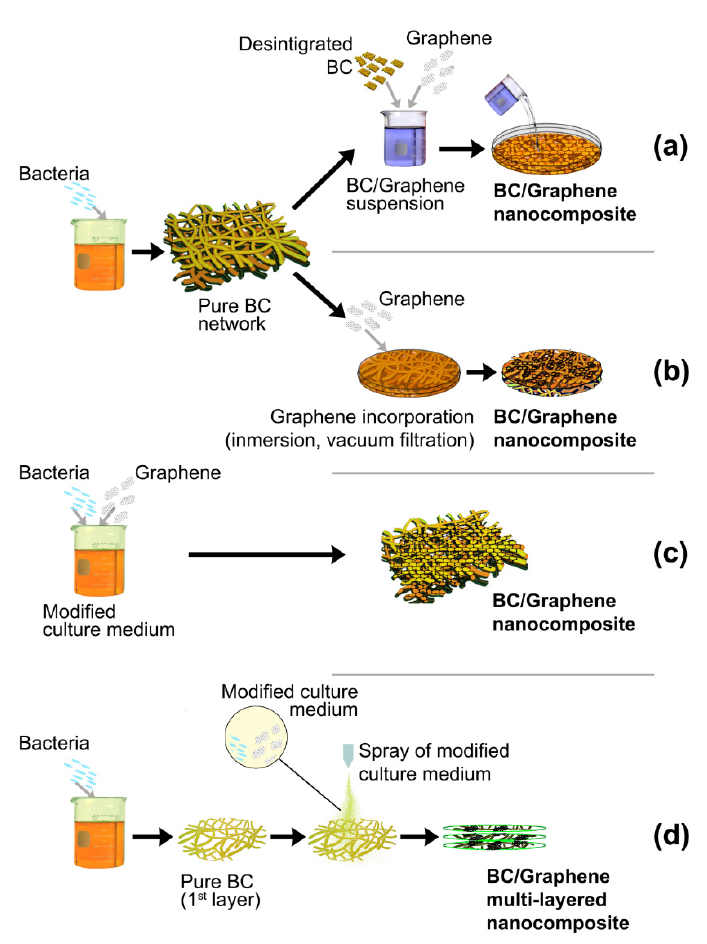
Figure 1. Processing routes reported for the preparation of BC- graphene oxide (GO)